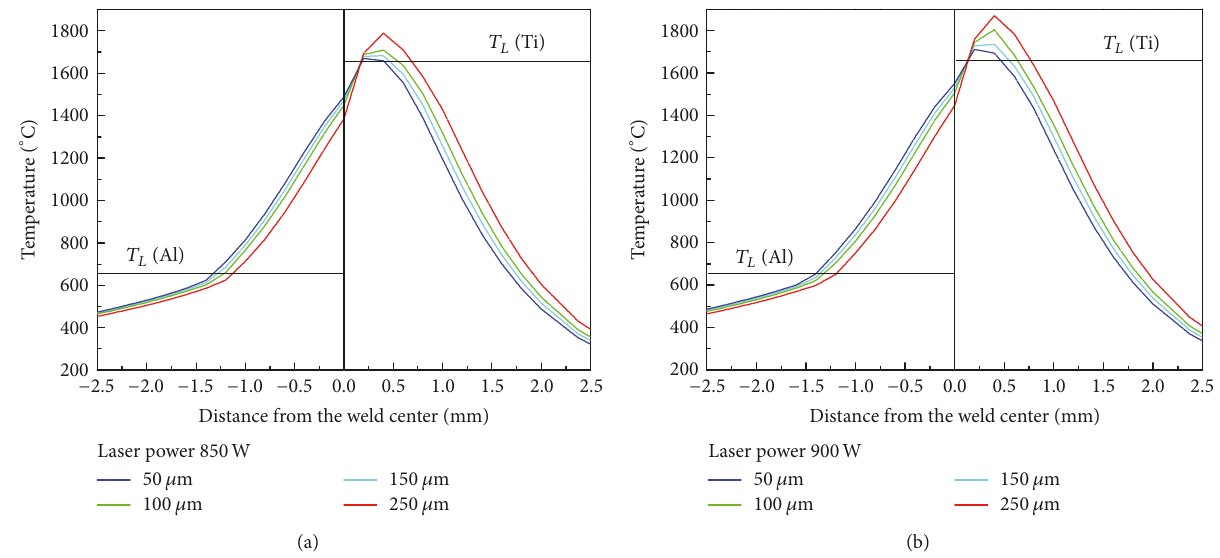
Figure 10: The dependence of computed temperatures on the distance from the weld centre for different laser offsets and the laser power of (a) 850 W and (b) 900 W.